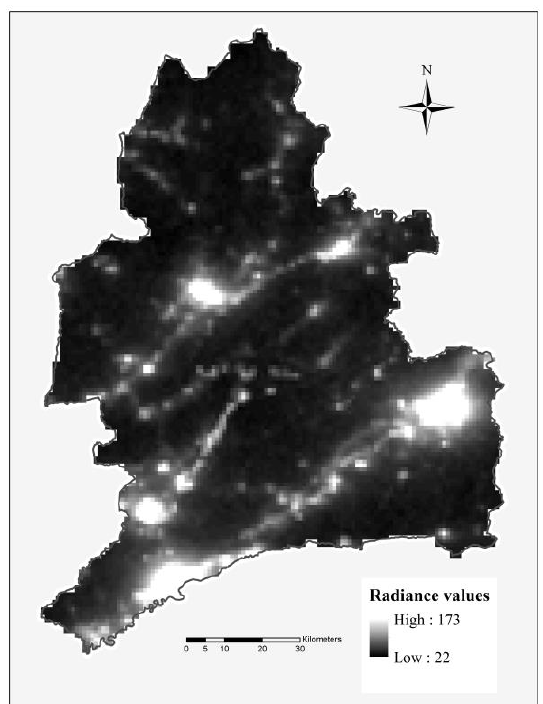
Figure 3. The night-time stable light (NSL) data of National Polar-Orbiting Partnership’s Visible Infrared Imaging Radiometer Suite (NPP-VIIRS) in 2017.